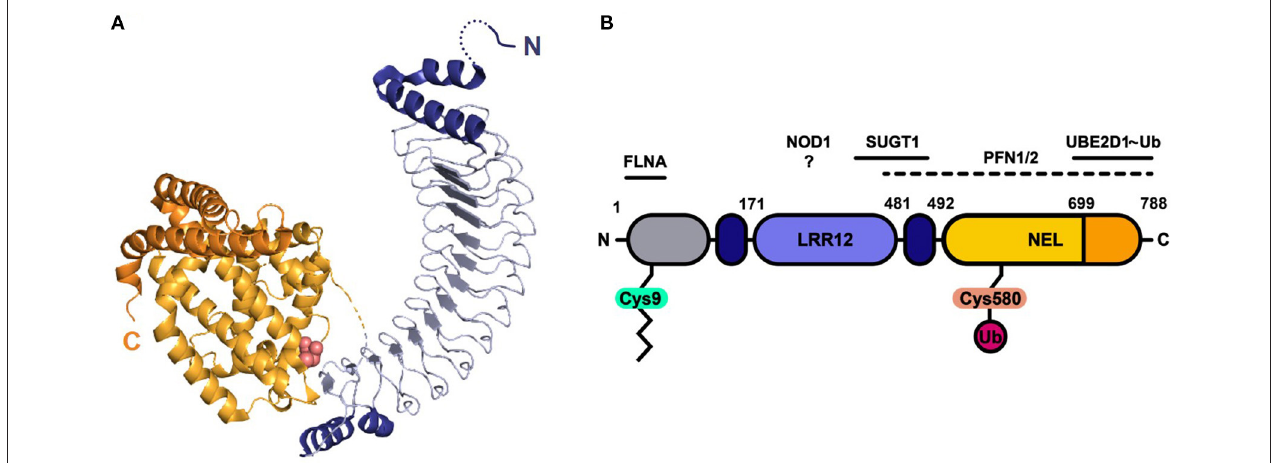
FIGURE 1 | Protein structure and domain architecture of S. Typhimurium effector SspH2. (A) The ribbon diagram represents the by X-ray crystallography solved protein structure of SspH2 residues 166-783 (PDB 3G06), consisting of two main domains: the leucine-rich repeat (LRR) domain (blue) and the novel E3 ligase (NEL) domain (orange). Both sides of the 12 LRRs are capped with alpha helices (dark blue). The NEL domain harbors the catalytic Cys residue (pink atoms shown in spheres) and can be further subdivided into a globular domain (light orange) and a 2-helical C-terminal extension (dark orange). (B) A linear representation of the SspH2 architecture and its reported host interactors ubiquitin conjugating enzyme E2 D1 (UBE2D1), suppressor of G2 allele of SKP1 homolog (SUGT1), nucleotide binding oligomerization domain containing 1 (NOD1), profilin 1 (PFN1) and 2 (PFN2) and filamin-A (FLNA). SspH2 is S -palmitoylated (zigzag line) at Cys9, attaching the effector to the host membrane. As an E3 ubiquitin (Ub) ligase, catalytic Cys580 of SspH2 is involved in the transfer of Ub to substrate proteins. Color-coding of domains is done according to panel (A) . Gray region represents sequence not covered in the crystal